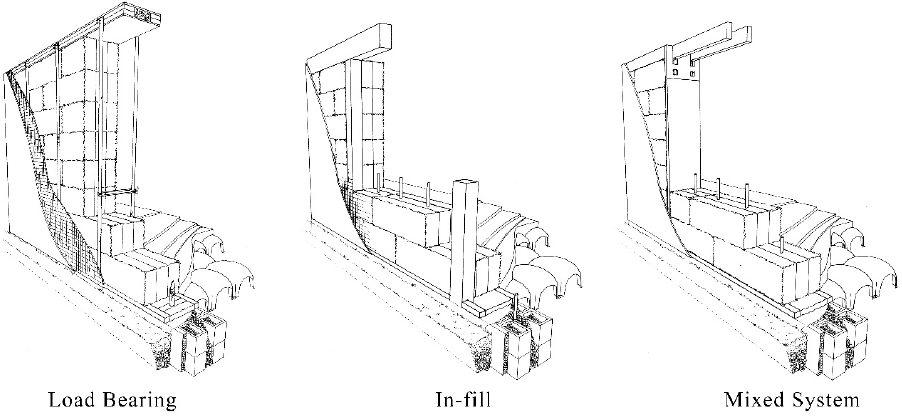
Figure 1. Building systems [3].